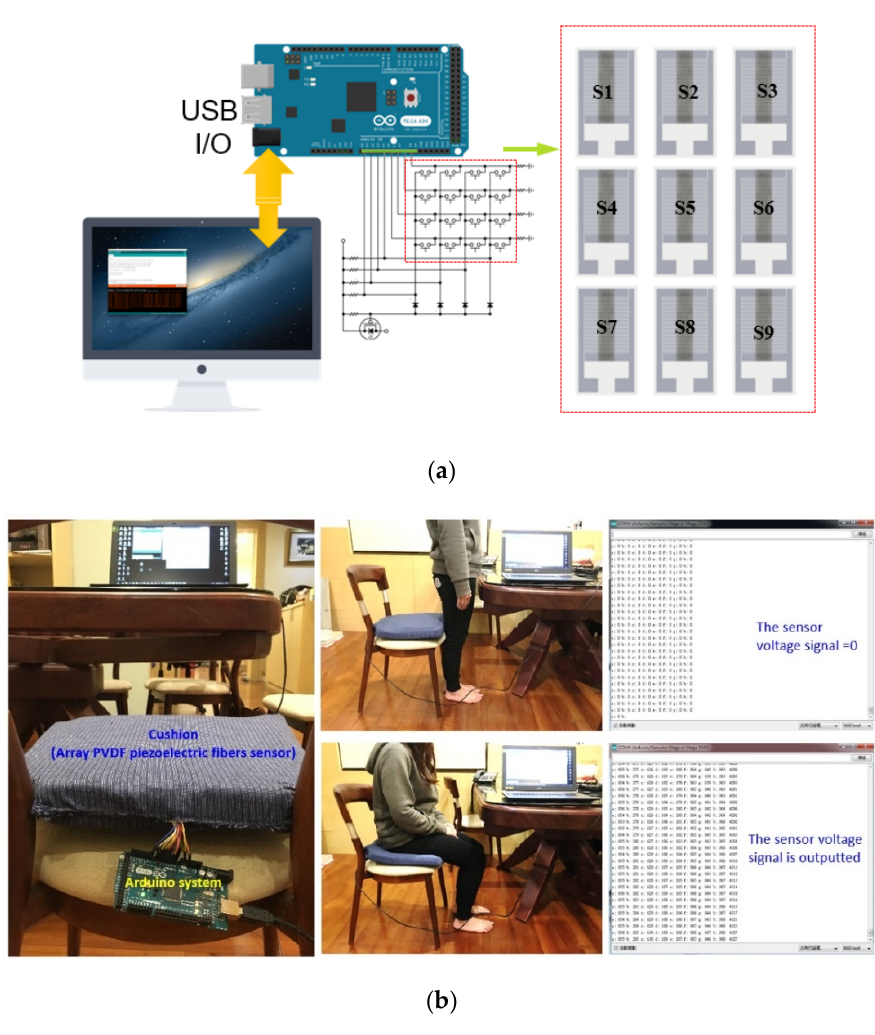
Figure 22. ( a ) Controller circuit model system (Arduino MAGE) and combining the sensing method of an array; ( b ) The patient standing voltage output signal was zero, the patient sitting appeared at a different voltage output signal.